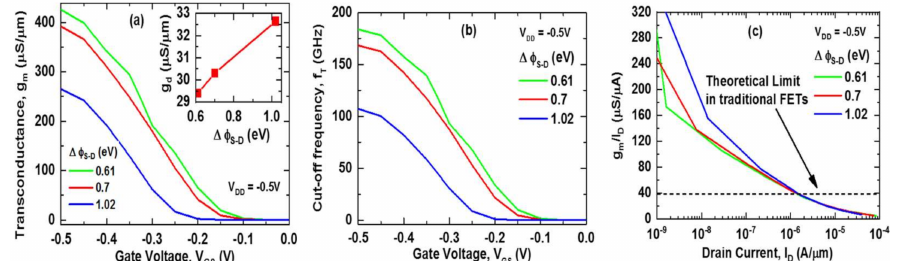
Figure 9. ( a ) Transconductance (g m ), ( b ) cut-off frequency (f T ) as function of Gate Voltage (V GS ), and ( c ) transconductance to current ratio (gm/Id) as function of drain current (Id) at V DD = − 0.5 V; inset shows output conductance (g d ) at V DD = V GS = − 0.5 V as a function of work function differ- ence ( ∆ φ S-D